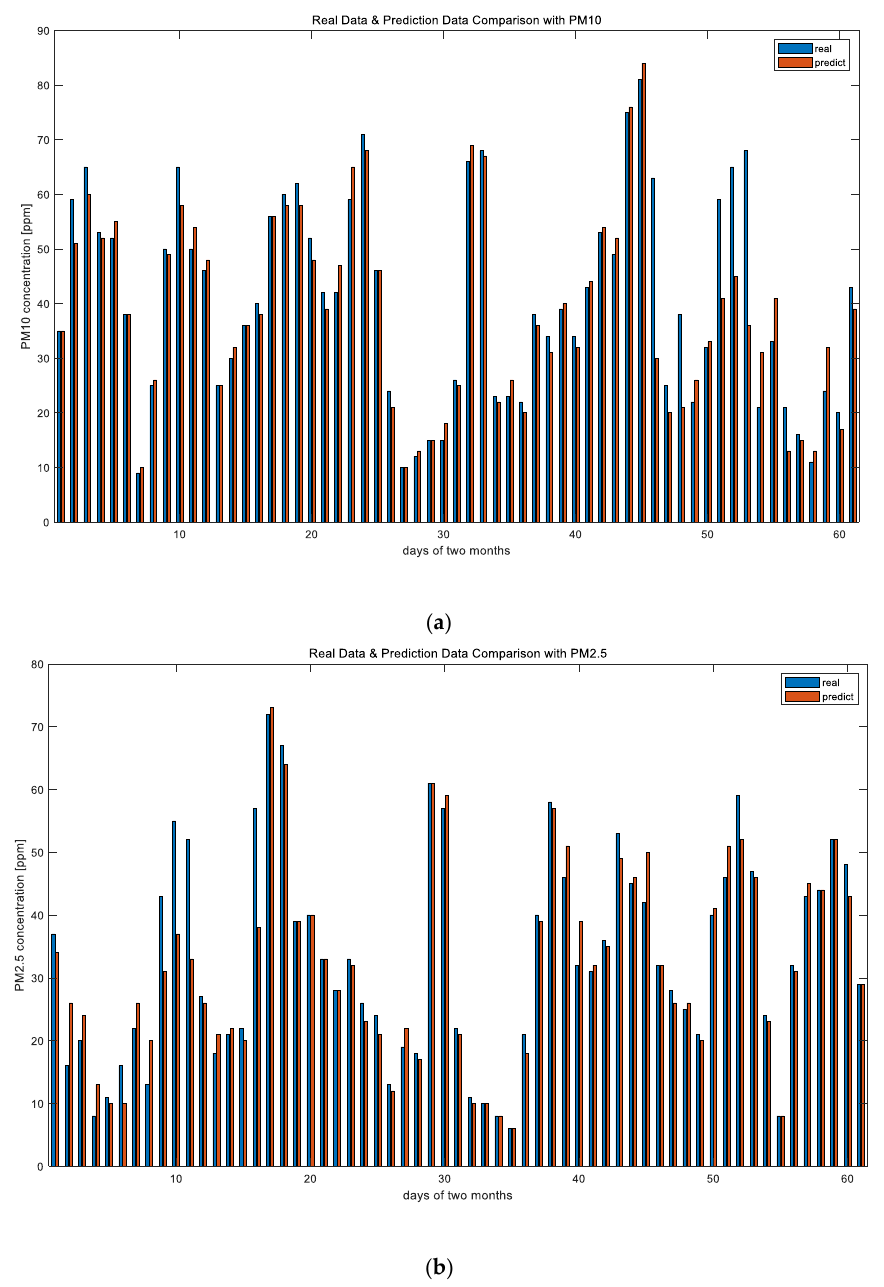
Figure 9. Data comparison with real data and predicted data for ( a ) PM10 and ( b ) PM2.5.